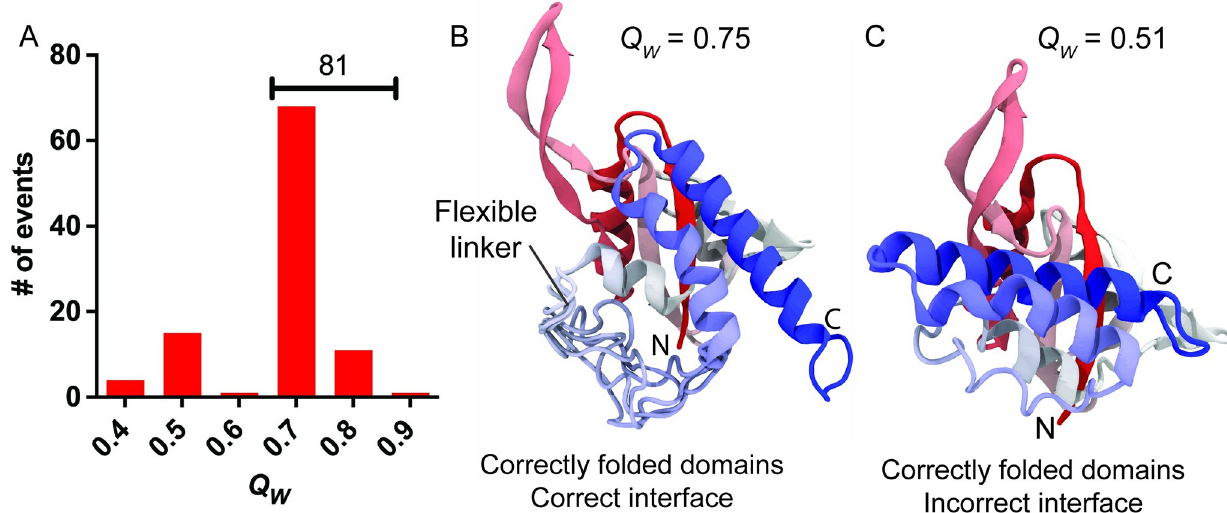
Fig 3. Refolding efficiency of α RfaH. (A) Distribution of tertiary contacts ( Q W ) in the final structure of the 100 refolding simulations generated for α RfaH using a single memory. (B-C) Representative final structures after α RfaH refolding with high (B) and low (C) Q gradient from red (N-terminus) to blue